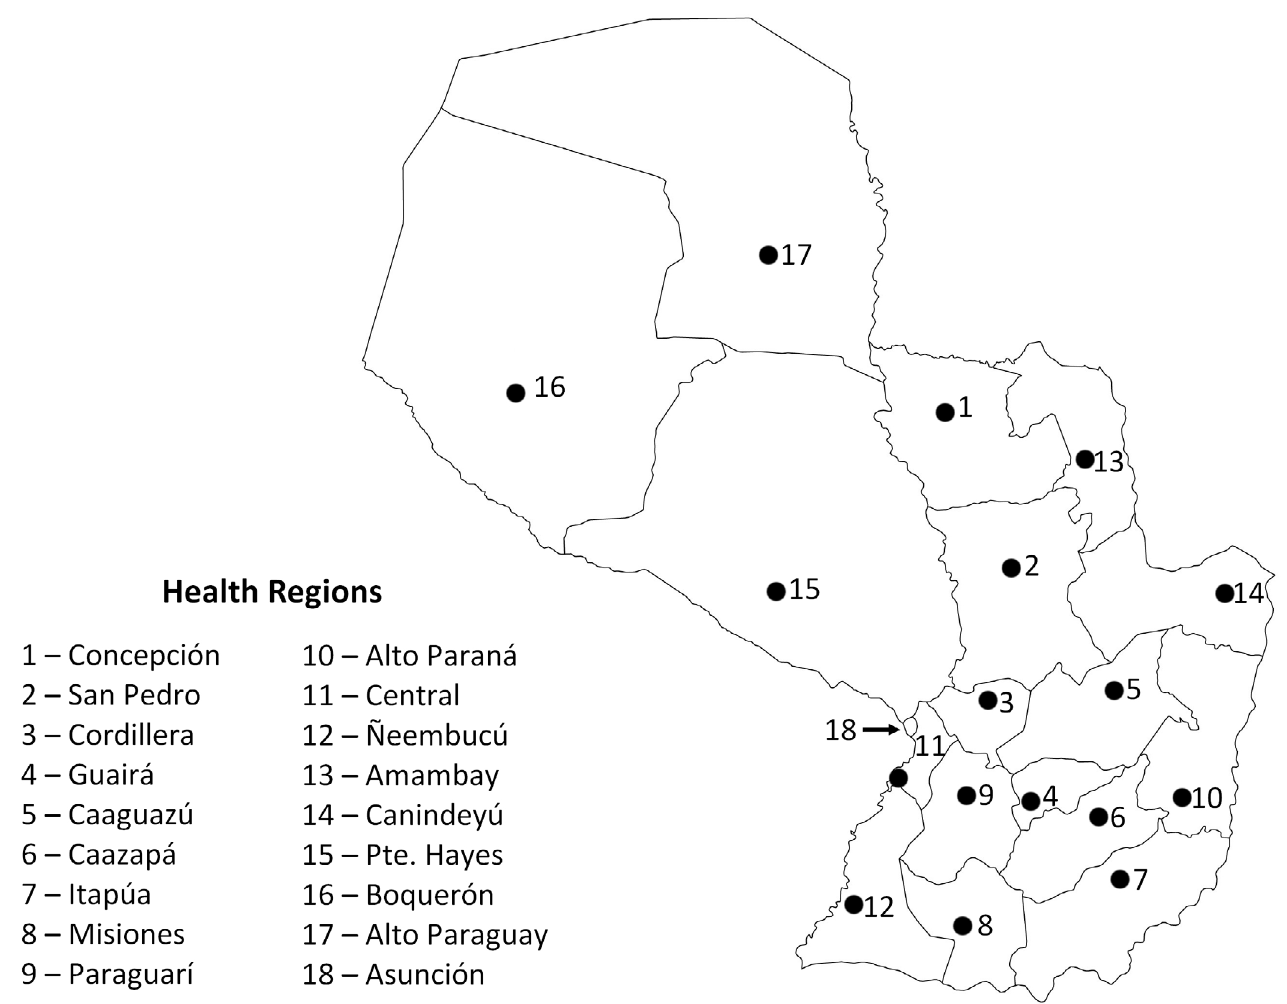
Figure 1. Map of Paraguay showing the eighteen Health